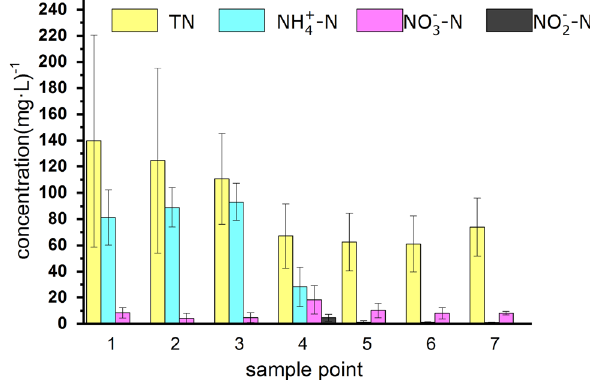
Figure 2. Variation of TN, NH 4 + -N, NO 3 -N and NO 2 -N at different sample